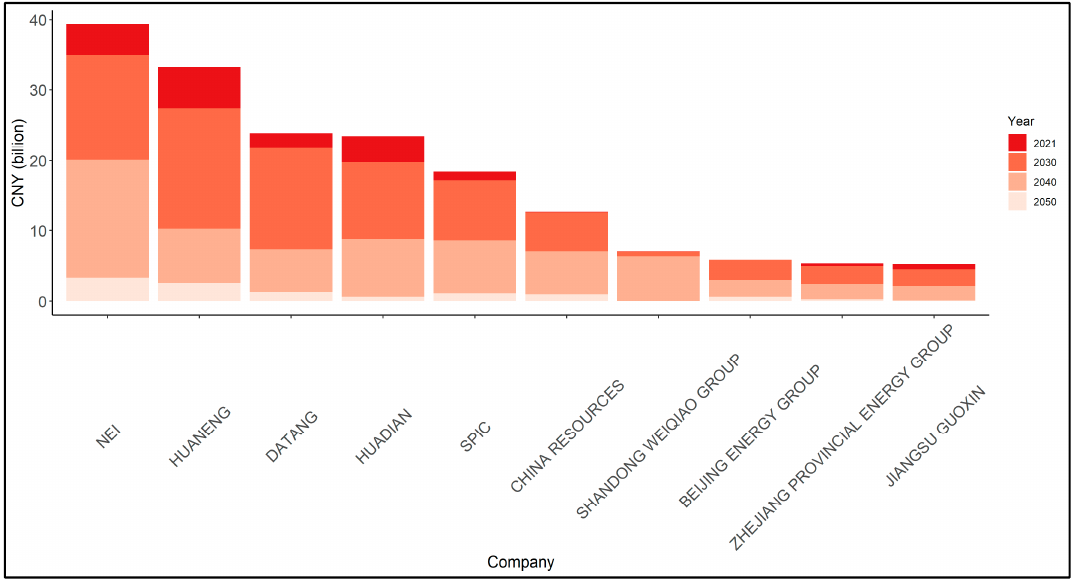
Figure 9. Largest parent companies by direct and indirect contribution to total tax revenues from coal, 2021–2050 (B